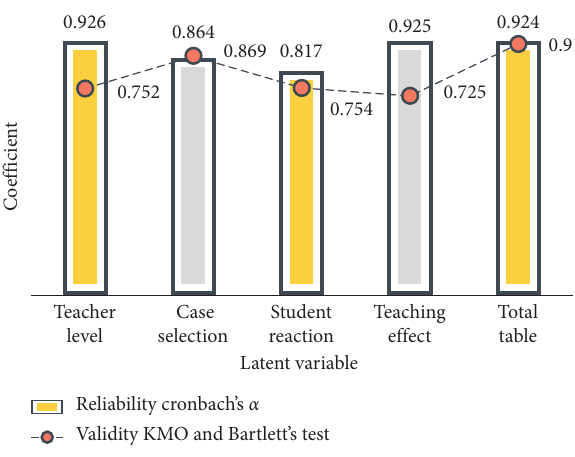
Figure 4: Reliability and validity test